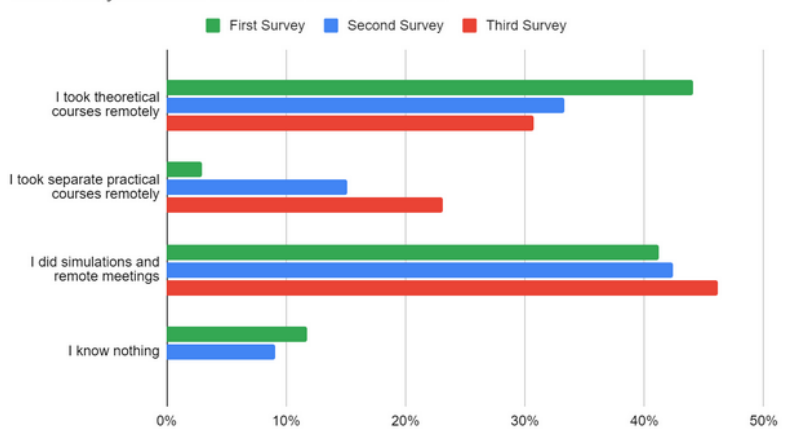
Figure 5. Remote class perceptions from